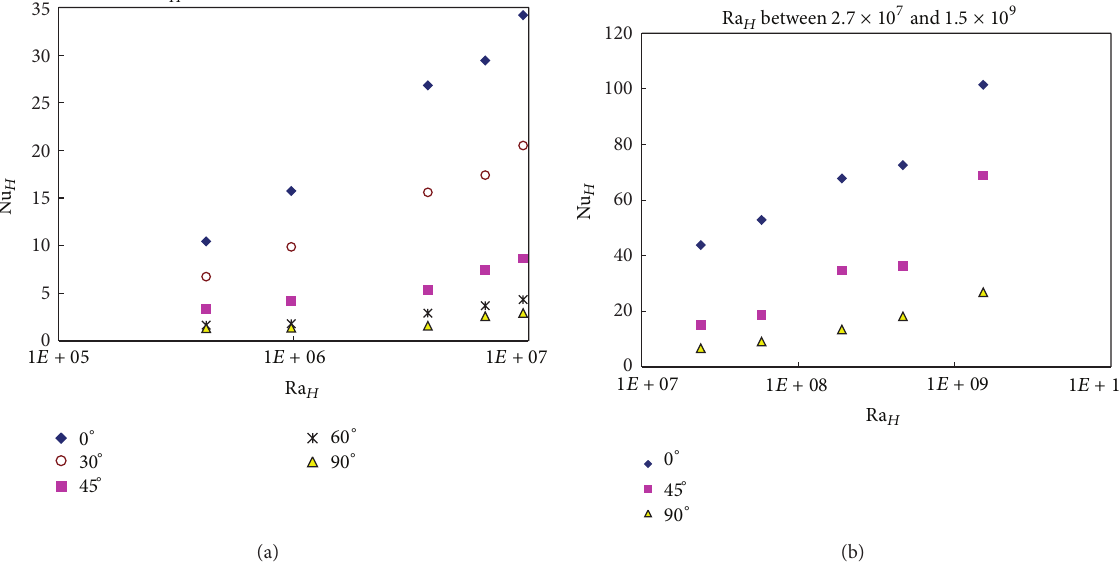
Figure 7: Variation of the Nu 𝐻 with Ra 𝐻 for different inclinations.